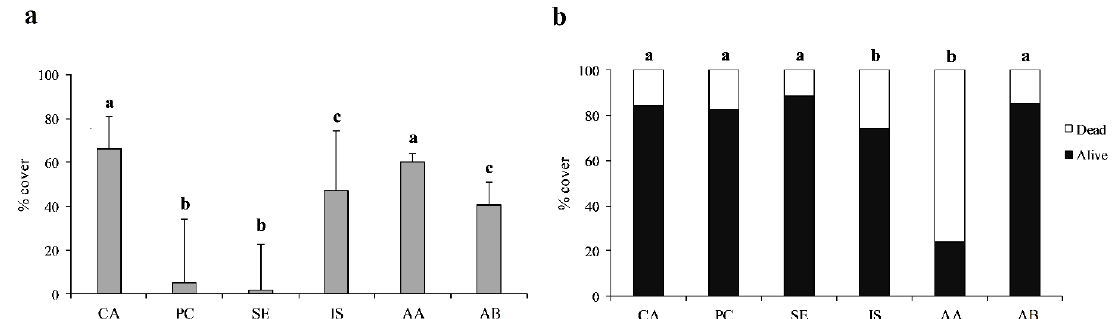
Figure 5. ( a ) Percentage of total (live and dead) rhodolith cover ( ± SD) at the investigated sites. ( b ) Percentage of live vs. dead thalli at each site. CA, Capri; PC, Punta Campanella; SE, Secchitiello; IS, Ischia; AA, Acciaroli A; AB, Acciaroli B. Different letters (a, b, and c) indicate significant differences between sites.